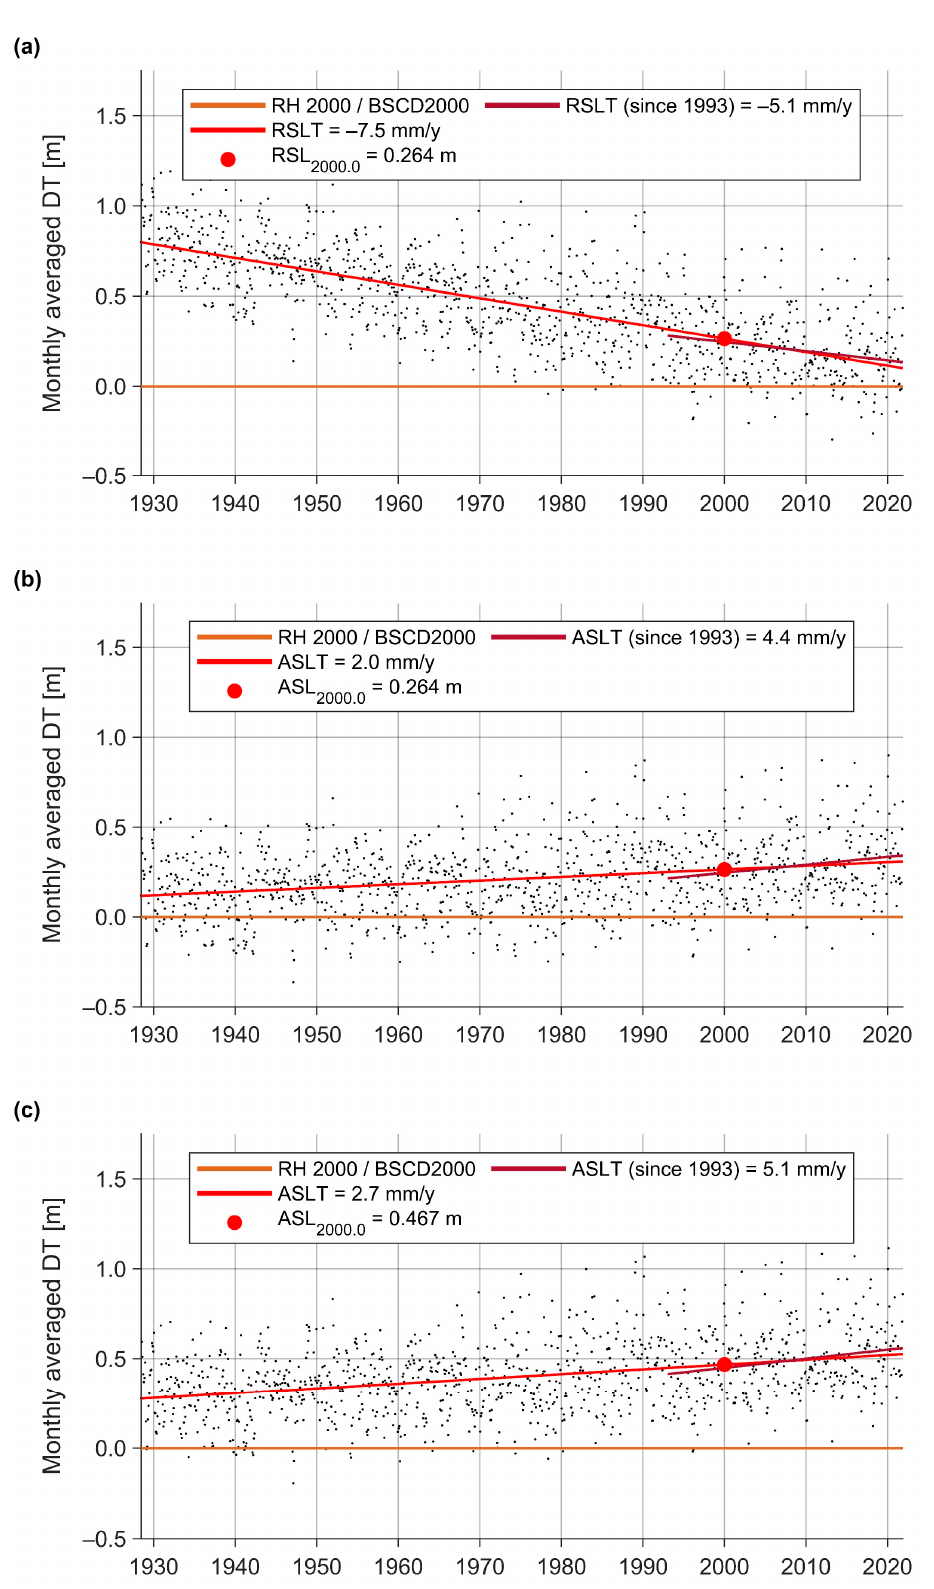
Figure 4. Monthly averaged ( a ) relative and ( b ) absolute DT of Ratan TG (cf. Figure 2 for its location) and the estimated sea level trends. In ( c ) are presented absolute DT and the estimated sea level trends containing purposefully induced errors (i.e., VLM geocentric and an arbitrary reference epoch 1980.0 are used).